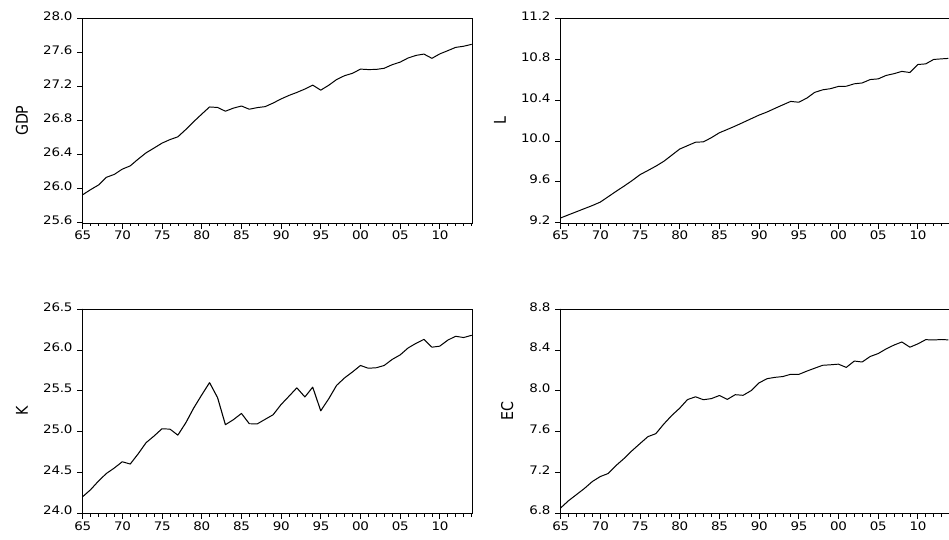
Figure 1. GDP, K, L, and EC. Sources: World Bank [49], Secretary of Energy [29], and The Conference Board Total Economy Database [52].